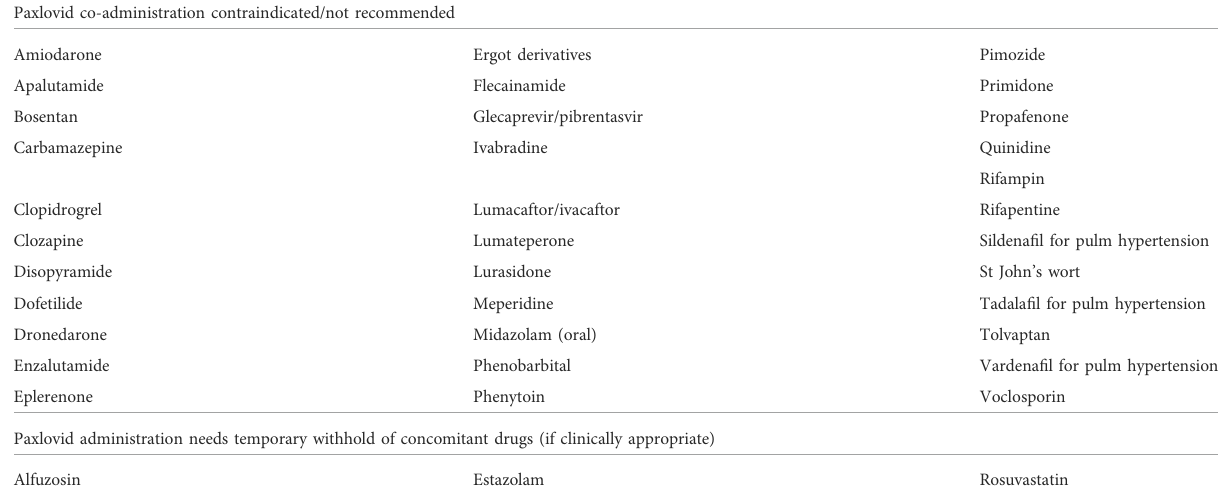
TABLE 1 Main drug-drug interaction of nirmatrelvir/ritonavir (Paxlovid). Paxlovid co-administration contraindicated/not